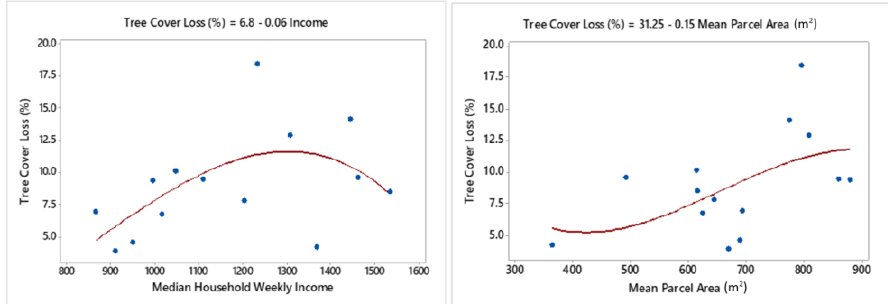
Figure 13. Sample level tree cover loss versus median household income ($AUD) and mean parcel area (m 2 ). Remote Sens. 2020 , 12 , x FOR PEER REVIEW